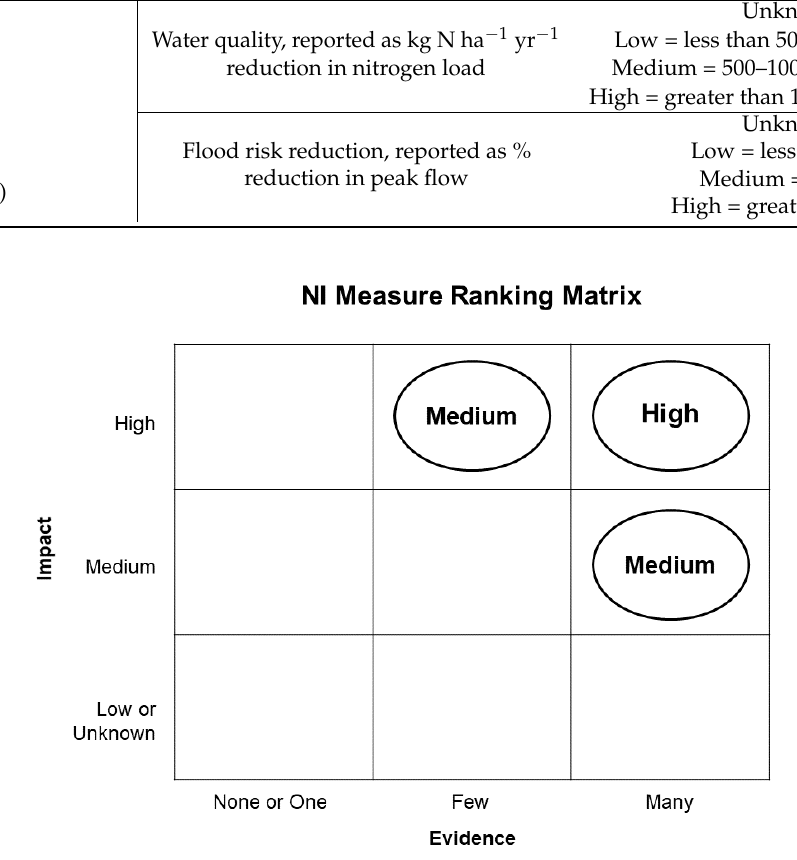
Figure 1. Matrix used to rank measures by impact and evidence. Measures for which many publications report High impact were considered “High” priorities for implementation, whereas measures for which a few studies reported High impact, or many studies reported Medium impact were considered “Medium” priority for implementation.